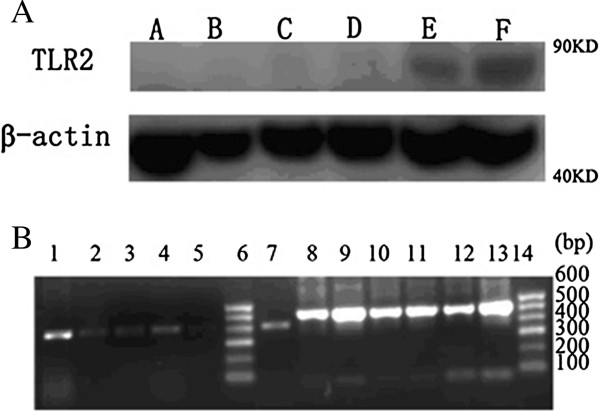
Expression of TLR2 in splenocytes of different vaccinated groups on day 2 after infection with S. aureus. (A) Western blot detection of TLR2 in splenocytes. Lane A: PBS group; lane B pEGFP-C2 group; lane C pEGFP /HA2 group; lane D pEGFP/Ag85A group; lane E pEGFP/Ag85A-HA2 group; lane F iPR group. (B) RT-PCR detection of TLR2 in splenocytes. Lanes 1, 8: pEGFP/Ag85A-HA2 group; lanes 2, 9: pEGFP-C2 group; lanes 3, 10: pEGFP /HA2 group; lanes 4, 11: pEGFP/Ag85A group; lanes 5, 12: PBS group; lanes 7, 13: iPR group. Lanes 1–5, 7: TLR2 (410 bp); lanes 8–13: GADPH (531 bp); lanes 6, 14: marker.